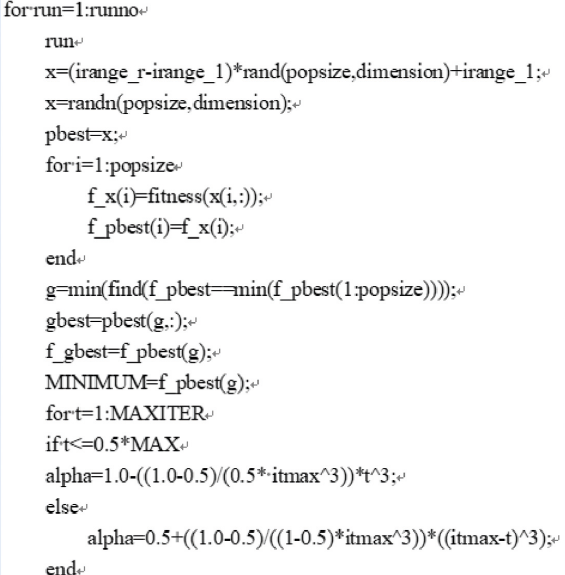
− 0.188036992457903]. Figure 4: Partial coding scheme for the IQPSO algorithm.